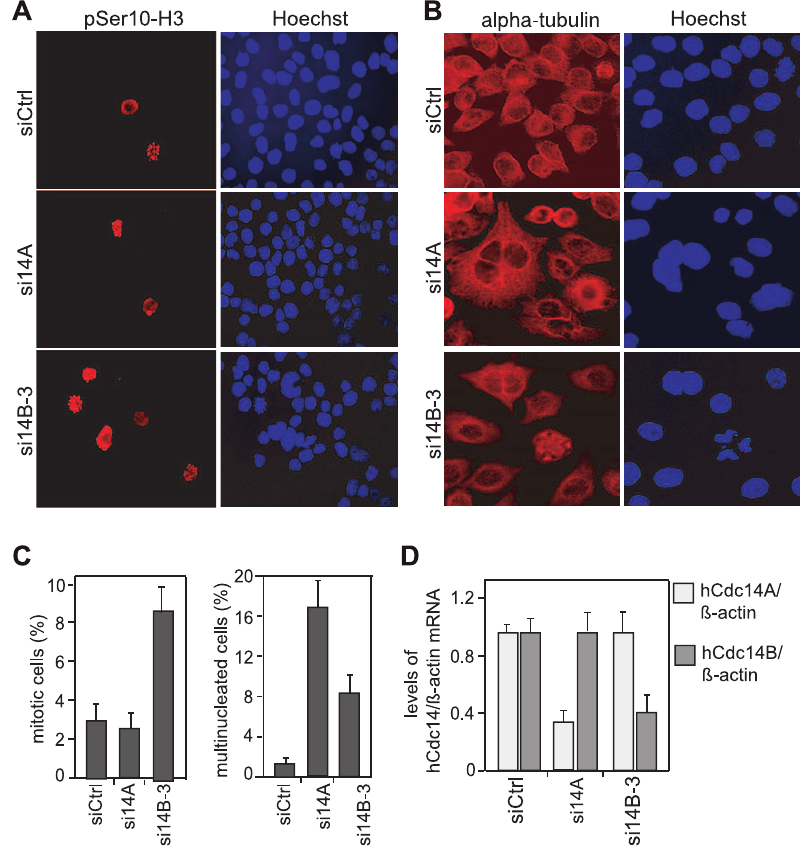
Figure 2. Silencing of hCdc14B leads to enrichment of mitotic cells. HeLa Kyoto cells were reverse transfected twice with a control-siRNA pool (siCtrl) or siRNAs that target hCdc14A (si14A) [24, Reference S1] or hCdc14B (si14B-3). During the second transfection equal numbers of cells were seeded onto coverslips, and 24 h after the second transfection cells were subjected to immunofluorescence microscopy and analysis of hCdc14 expression. A , B . Representative immunofluorescence images of HeLa Kyoto cells transfected with siCtrl, si14A, or si14B-3. Mitotic cells were visualized by immunostaining with histone H3-phospho-Serine-10 (pSer10-H3) antibodies (red) (A), multinucleated cells by staining with anti-alpha- tubulin antibodies (red) (B). DNA was counterstained with Hoechst 33342. C . Frequencies of mitotic and multinucleated cells. The data shown here represent means ( 6 SD) of three independent experiments derived from counting 400 cells each. D . hCdc14A and hCdc14B expression is reduced by the corresponding siRNAs. The graphs represent the mean levels ( 6 SD) of hCdc14A-mRNA (light bar) and hCdc14B-mRNA (dark bar) normalized to b - actin-mRNA as determined by RT-qPCR in three independent experiments.